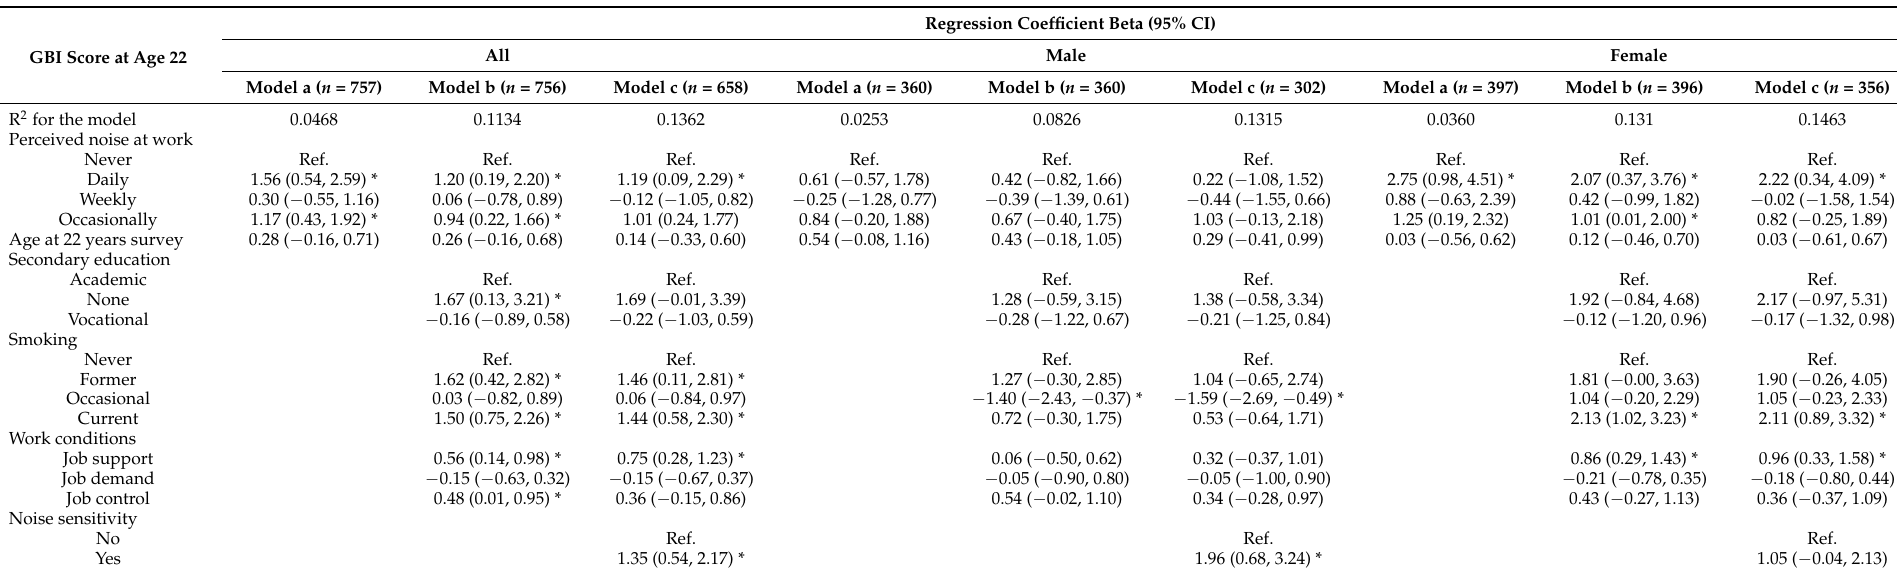
Table 2. Linear multivariable regression models of the association of depressive symptoms at age 22 using the GBI scale with perceived occupational noise exposure and selected covariates in young